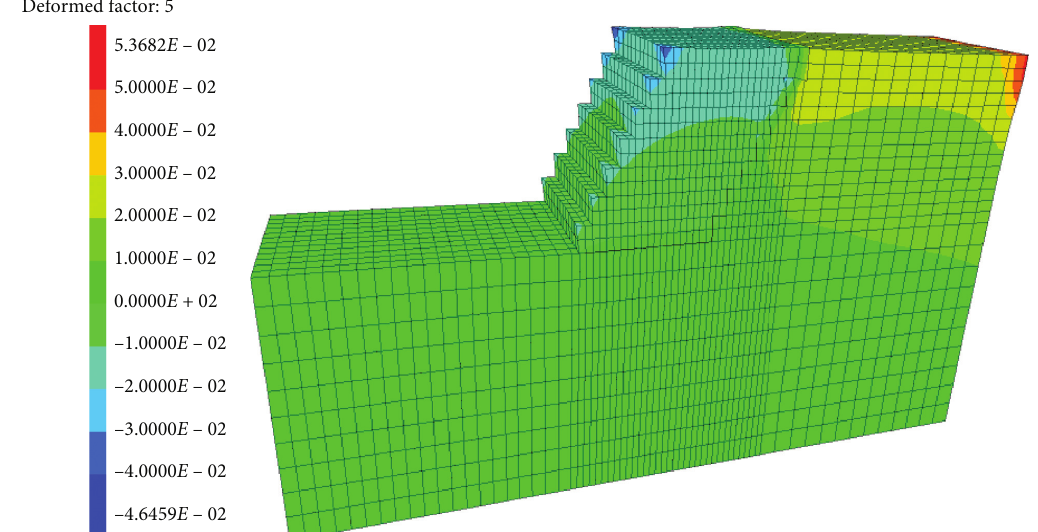
Figure 7: Displacement of the geocell flexible retaining wall at